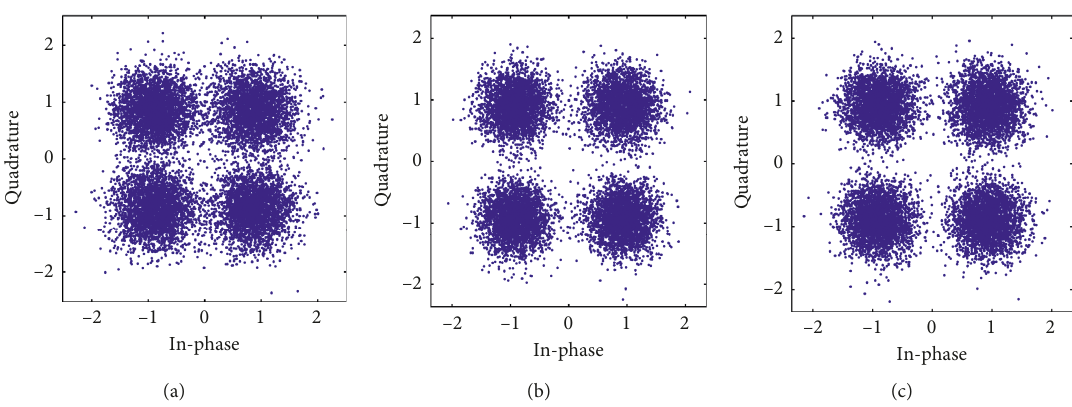
Figure 7: Symbol-constellation plots for VS01 using different algorithms: (a) P-DFE; (b) B-DFE; (c) T-DFE.